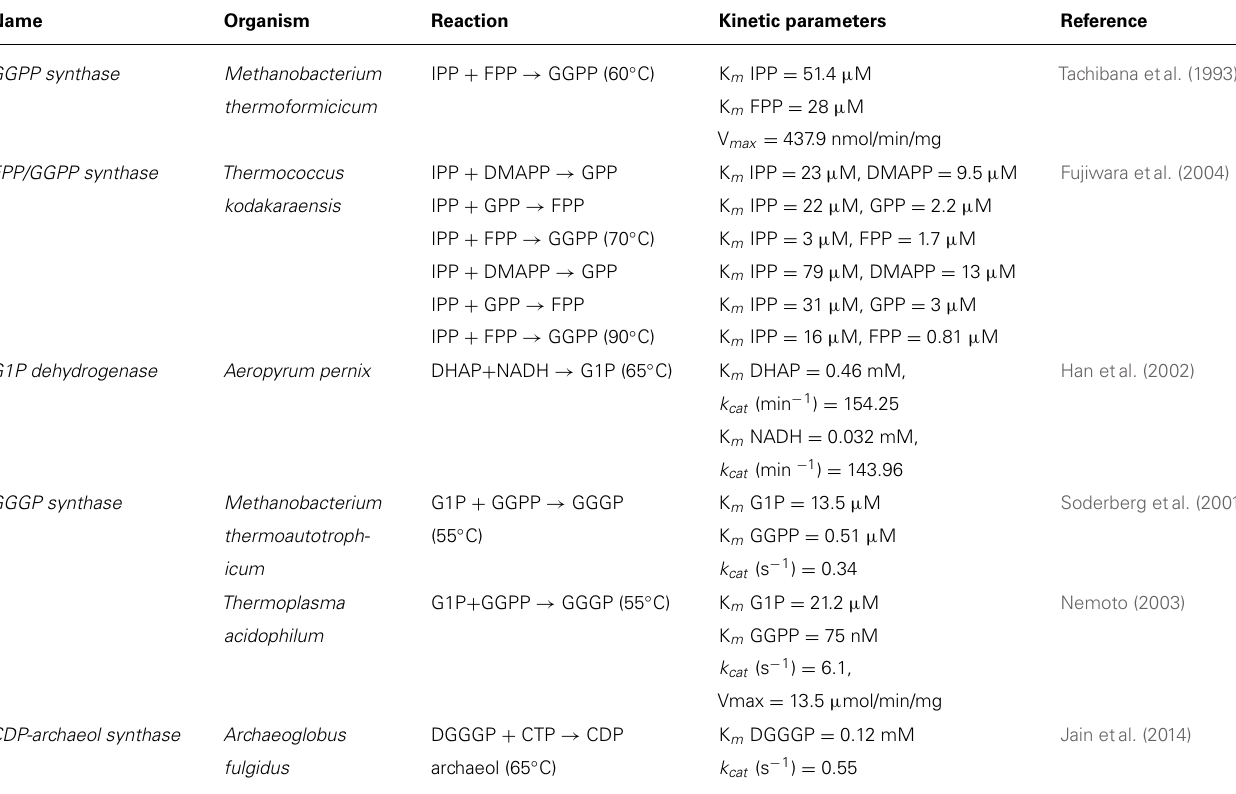
Table 1 | Summary of kinetic parameters derived for enzymes of archaeal lipid biosynthetic